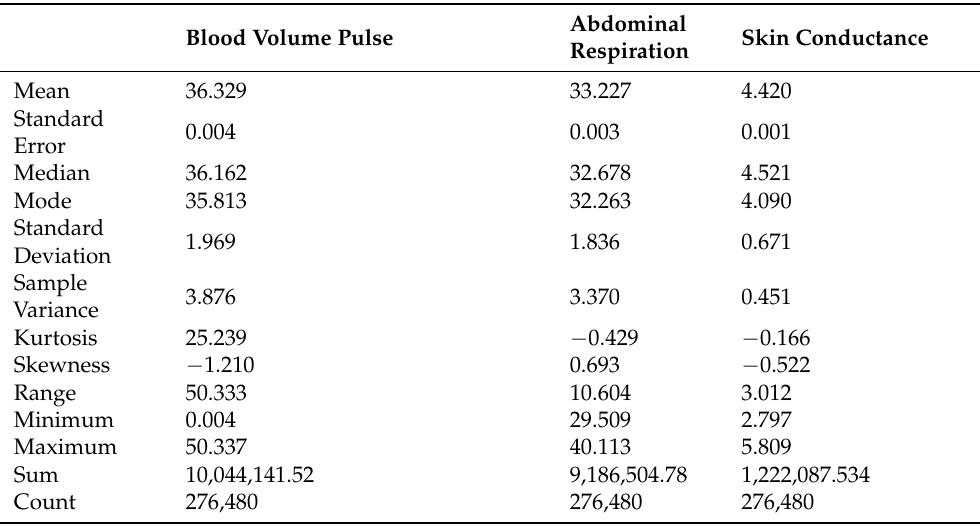
Table 2. Descriptive statistics of the signals from three physiological variables obtained during the ProComp5 measurements. They describe the signals shown in Figure